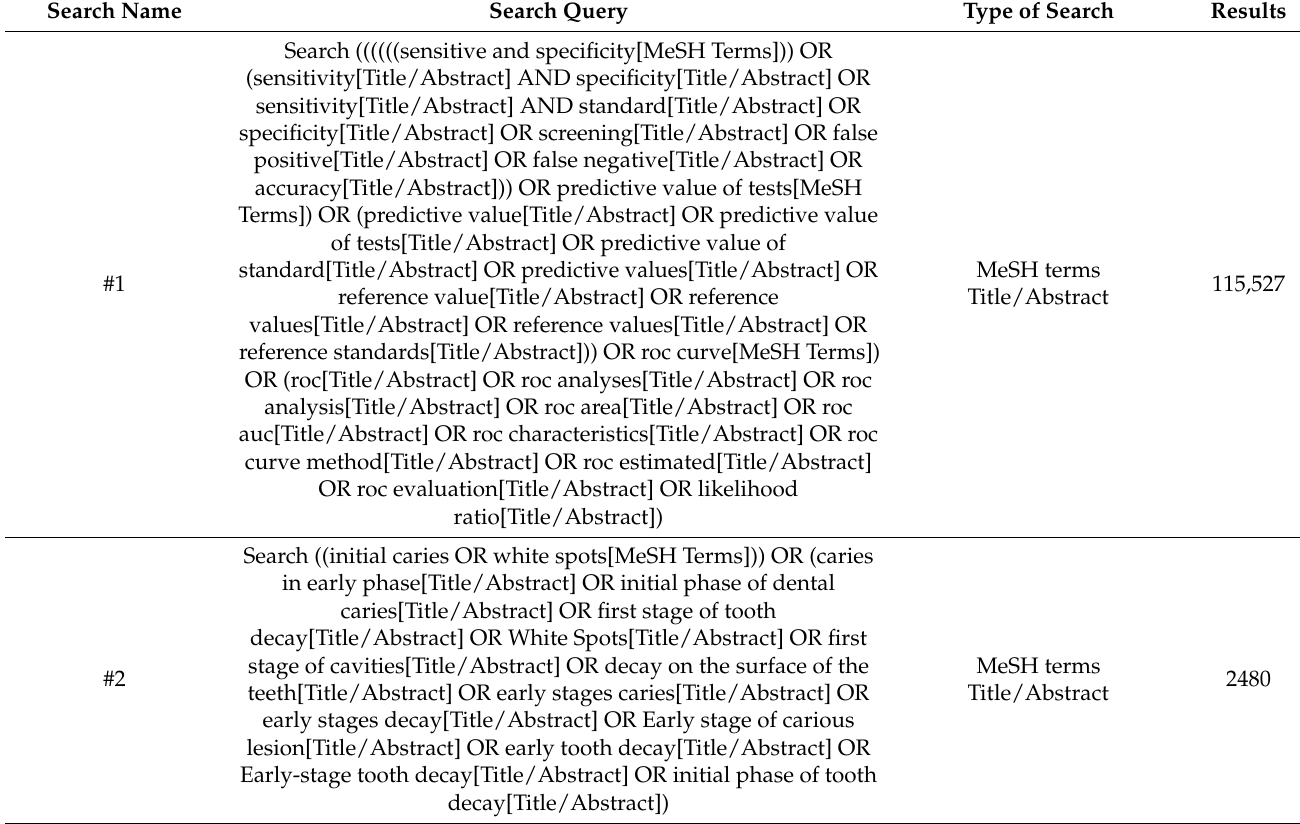
Table A2. Cochrane search: diagnostic value of fluorescence methods, visual inspection and photographic visual examina- tion in initial caries